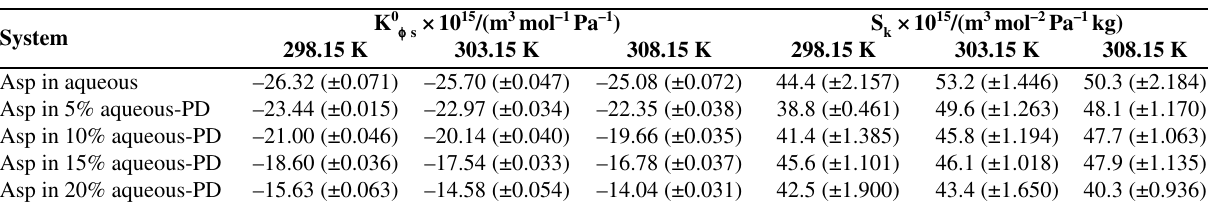
experimental slopes, S , and standard deviations of linear regression (in paren- ,s, k